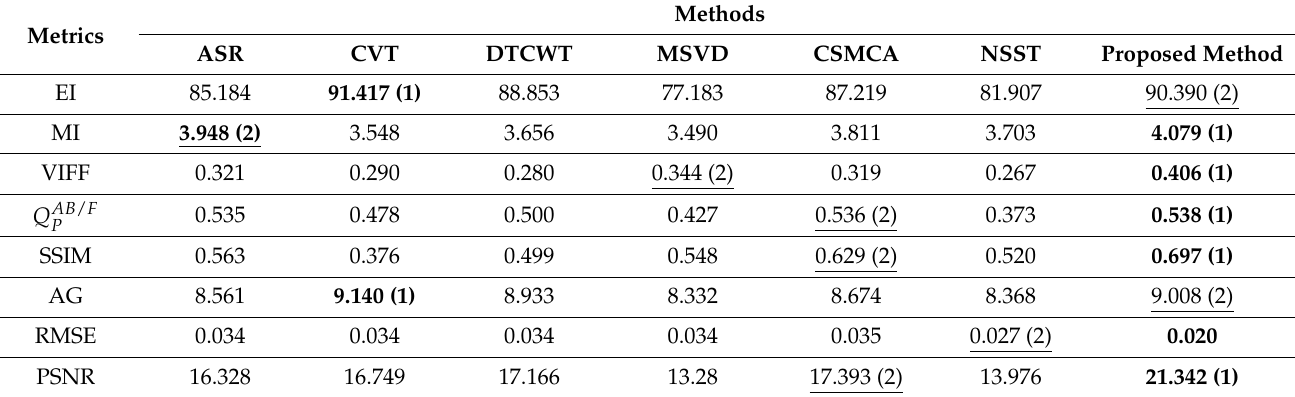
Table 3. Quantitative analysis of various fusion methods for MRI-CT